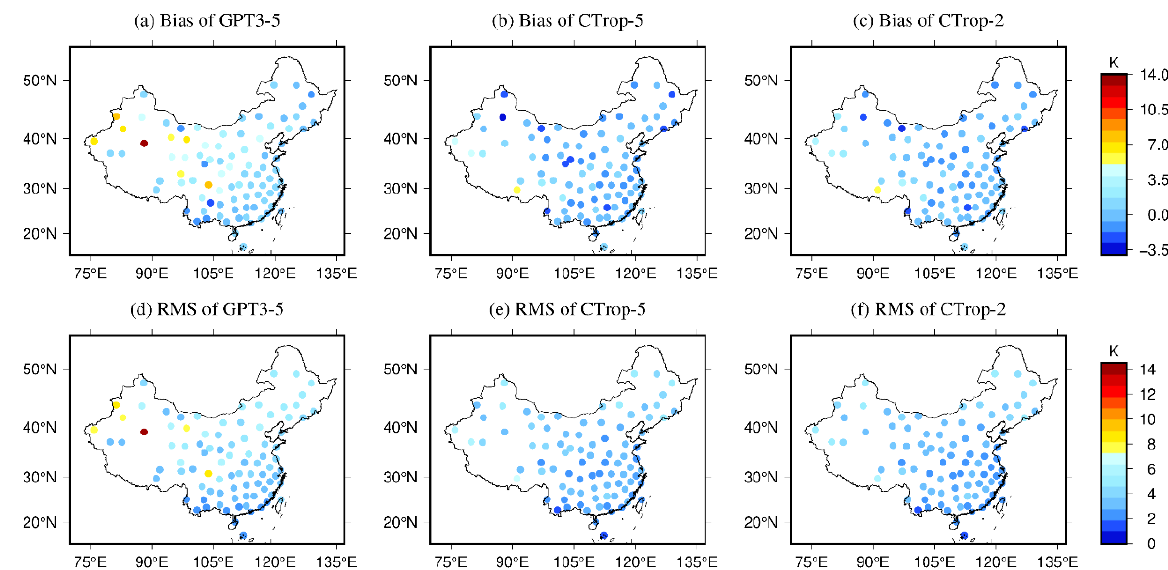
Figure 14. Distribution of the performance of temperature in different resolutions of the CTrop and GPT3 models validated by radiosonde sites in 2017: ( a ) Bias of GPT3-5; ( b ) Bias of CTrop-5; ( c ) Bias of CTrop-2; ( d ) RMS of GPT3-5; ( e ) RMS of CTrop-5; ( f ) RMS of CTrop-2.